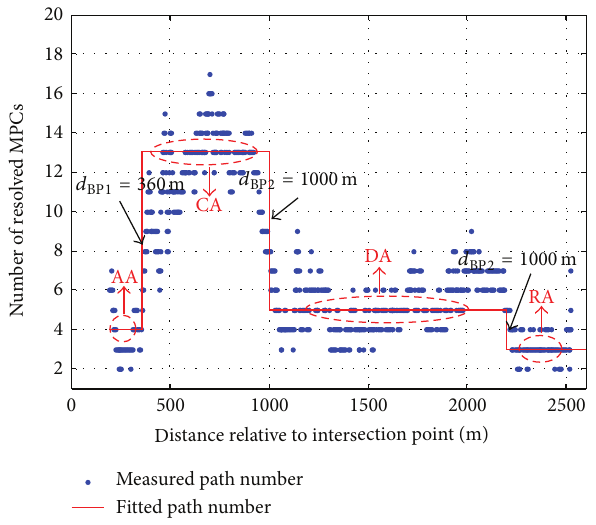
Figure 2: The resolvable MPC number in HSR hilly